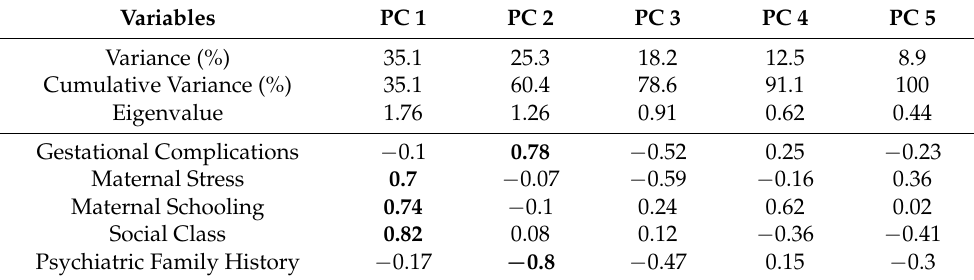
Table 1. Principal Component Analysis of environmental factors.